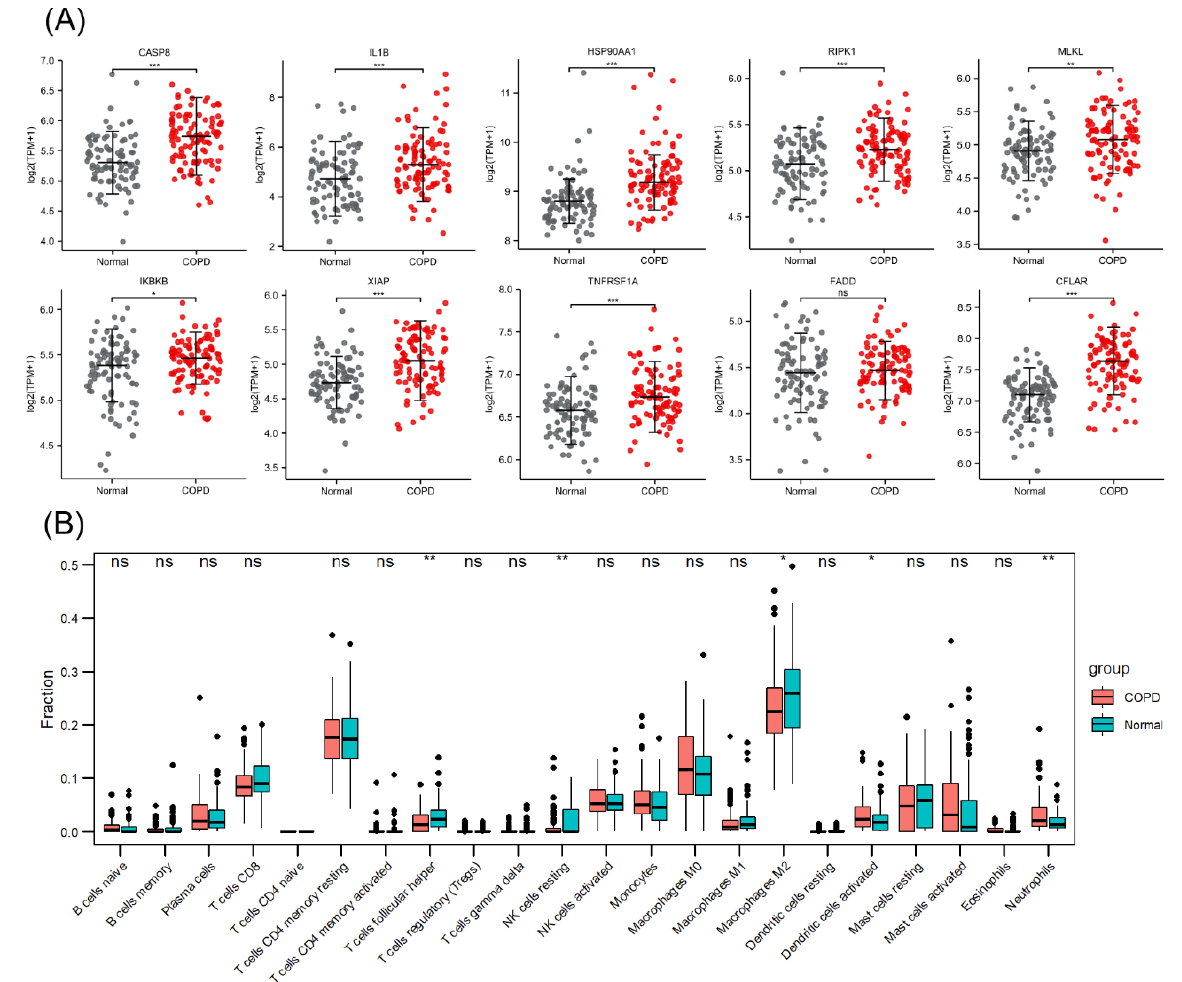
Figure 7. Validation of necroptosis-related hub genes and immune infiltration in an external dataset. ( A ) Expression of 10 necroptosis-related hub genes. ( B ) Box plot of the immune cell proportions. ns p > 0.05, * p < 0.05, ** p < 0.01, *** p < 0.001.